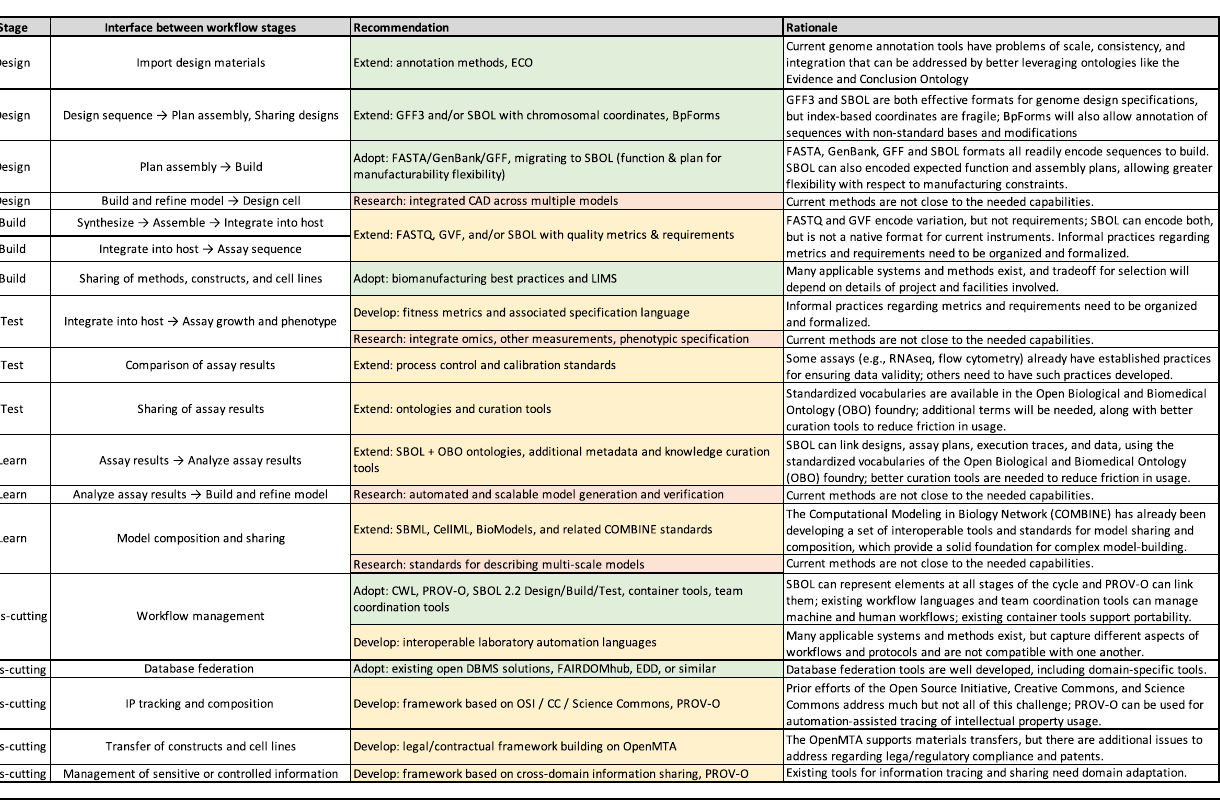
Table 2 Potential approaches for integrating the emerging gigabase engineering work fl ow, labeled for